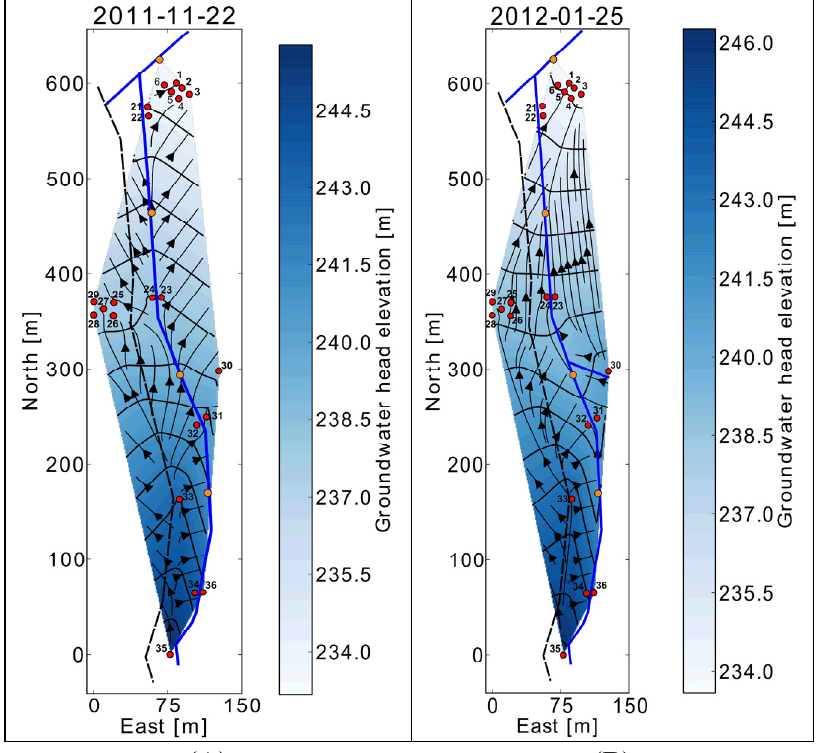
Figure 8. Groundwater head elevations (m a.s.l.) and flow directions along the Vollnkirchener Bach during a wetting up phase (22 November 2011–25 January 2012). ( A ) shows the initial groundwater flow directions (22 November 2011) and ( B ) groundwater flow directions at the end of the wetting up period (25 January 2012).Red dots indicate piezometers, orange dots stream depth observation points, and the dashed line a street. Arrows and contour lines show groundwater flow directions along the